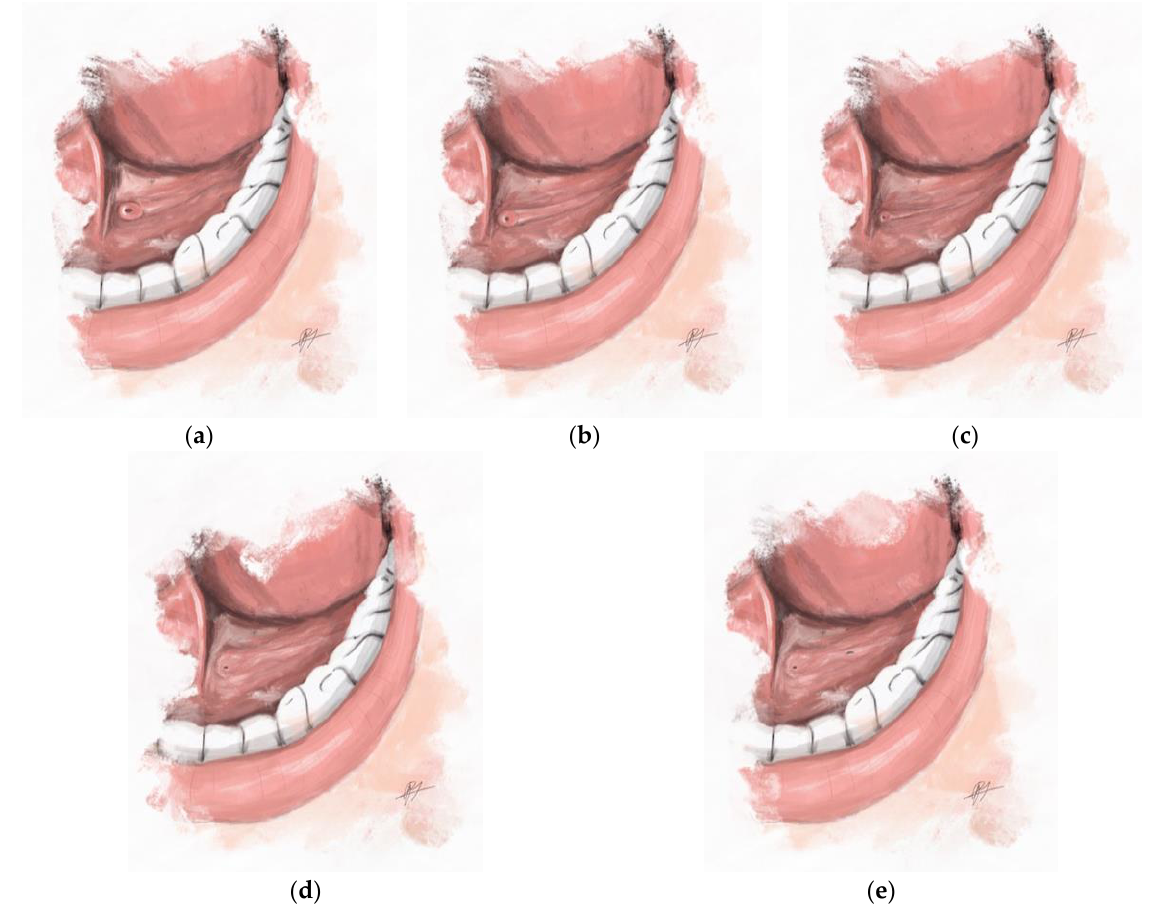
Figure 2. Graphical representation of different types of Wharton ’ s duct papillae. In ( a ), easy or estuary-like papilla (type A) can be seen. ( b ) depicts a normal papilla (type B) with evident orifice and papilla; and ( c ) demonstrates a difficult papilla (type C). ( d , e ) depict a substantially closed papillae (subtypes D I/II and D III , respectively). In last two figures, the orifice is barely visible. An oval-shaped fistula can be noted near the orifice in the last figure.